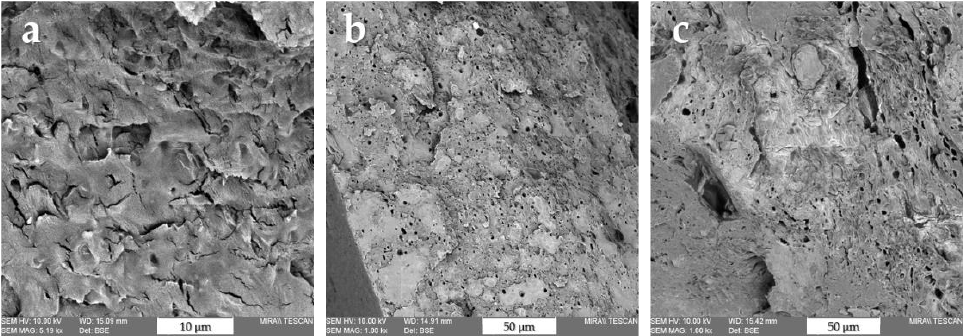
Figure 3. Effect of CaCl 2 addition on the mechanical properties of thermoplastic starch. ( a ) stress– strain curves and ( b ) Young’s modulus of virgin TPS, TPS/CaCl 2 10 wt% and TPS/CaCl 2 20 wt% composite films.